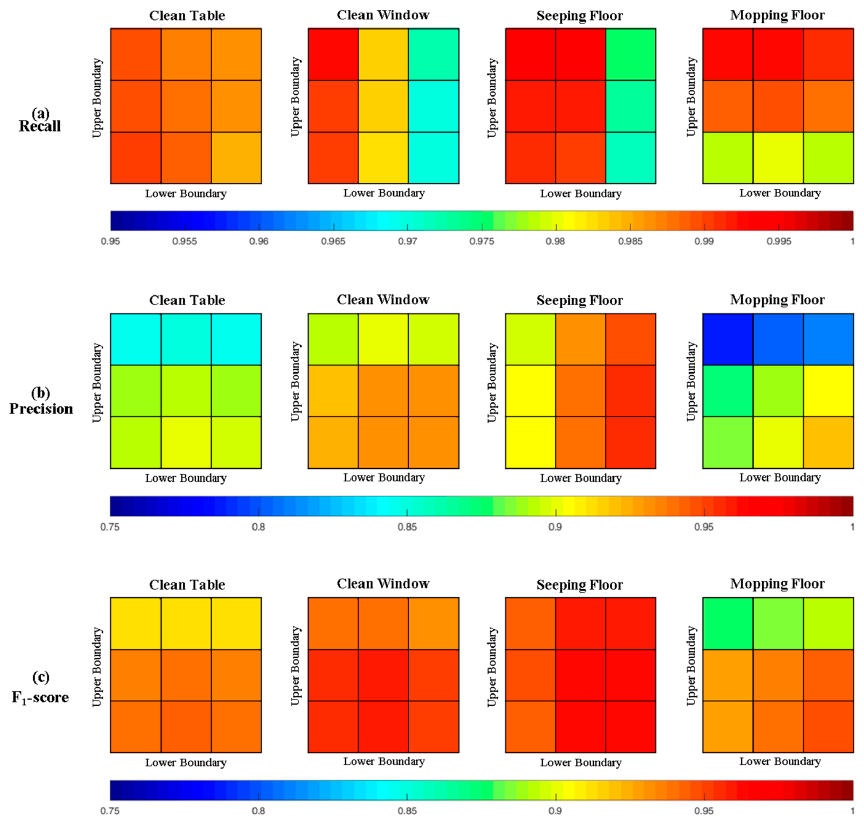
Figure 8. Average performance of three classifiers for four cleaning tasks in ( a ) recall; ( b ) precision;